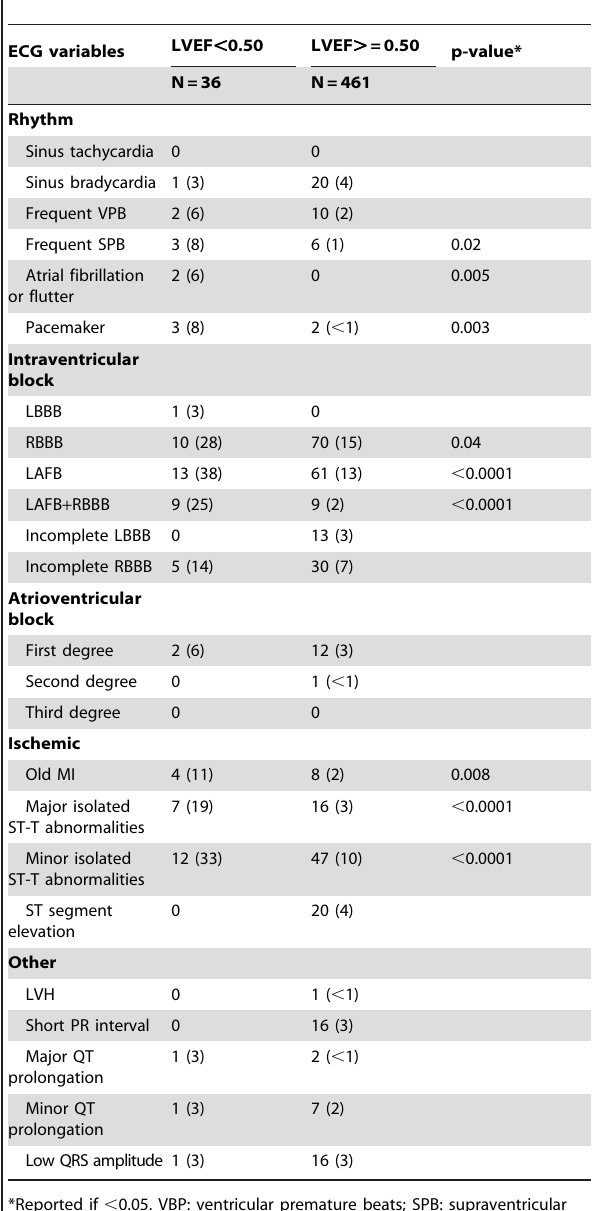
Table 3. ECG findings in T.cruzi seropositive blood donors by